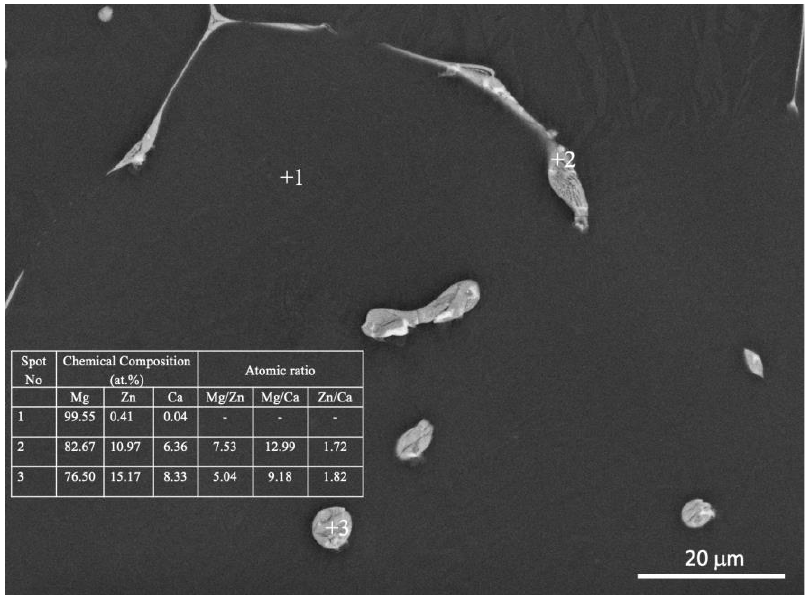
Figure 6. EDS analysis of the ZX10 alloy.